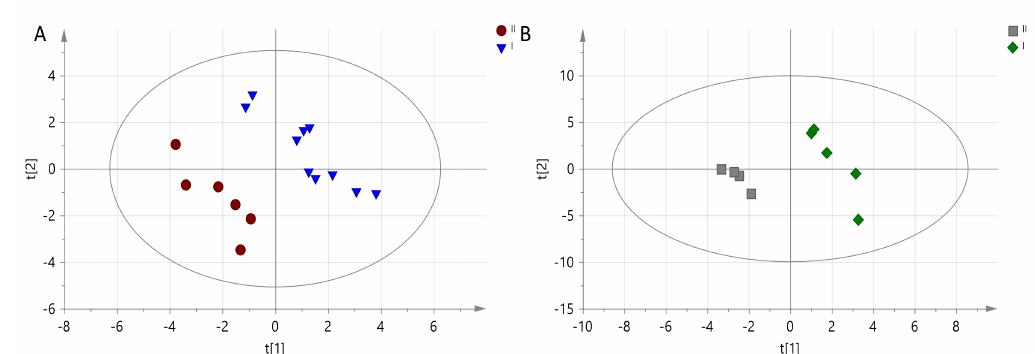
Figure 2. PLS-DA model obtained from LC-MS data for ( A ) 2nd time point and differences between Diet I (EPA + DHA rich prescription diet) marked and Diet II (maintenance diet) marked-R2X = 0.183, R2Y = 0.942, Q2 = N/A; ( B ) 3rd time point and differences between Diet I marked and Diet II marked-R2X = 0.334, R2Y = 0.981, Q2 =